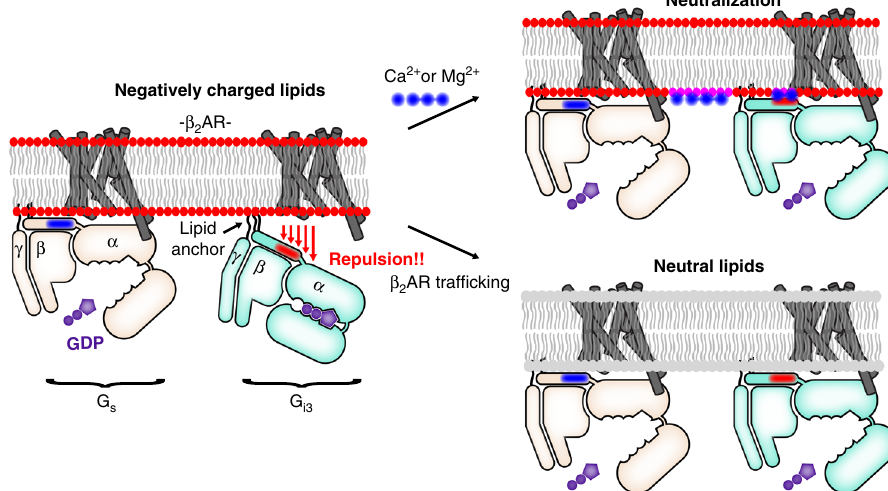
Fig. 6 Membrane charge is a tunable modulator of β 2 AR − G protein interaction. Models depict epinephrine-bound β 2 AR. Left: In negatively charged lipids, β − G fi cient, but β − G fi cient, in part because β − G 2 AR s coupling is ef 2 AR i3 coupling is relatively inef 2 AR i3 attraction is countered by membrane-G i3 repulsion. Speci fi cally, negatively charged lipids repel the negatively charged EDGE motif found on the amino terminal helix of G i3 (shown in red), a region that is positively charged in G s (shown in blue). Right: Two mechanisms that neutralize membrane charge facilitate β 2 AR coupling to G i3 . These mechanisms may play a role in G s -to-G i switching in cardiac myocytes. Top right: Ca 2 + and Mg 2 + stabilize a like-charge interaction between the membrane and the EDGE motif. (Note that the effect of Ca 2 + and Mg 2 + may extend beyond an effect on α N positioning.) Bottom right: Epinephrine-stimulated β 2 AR traf fi cs